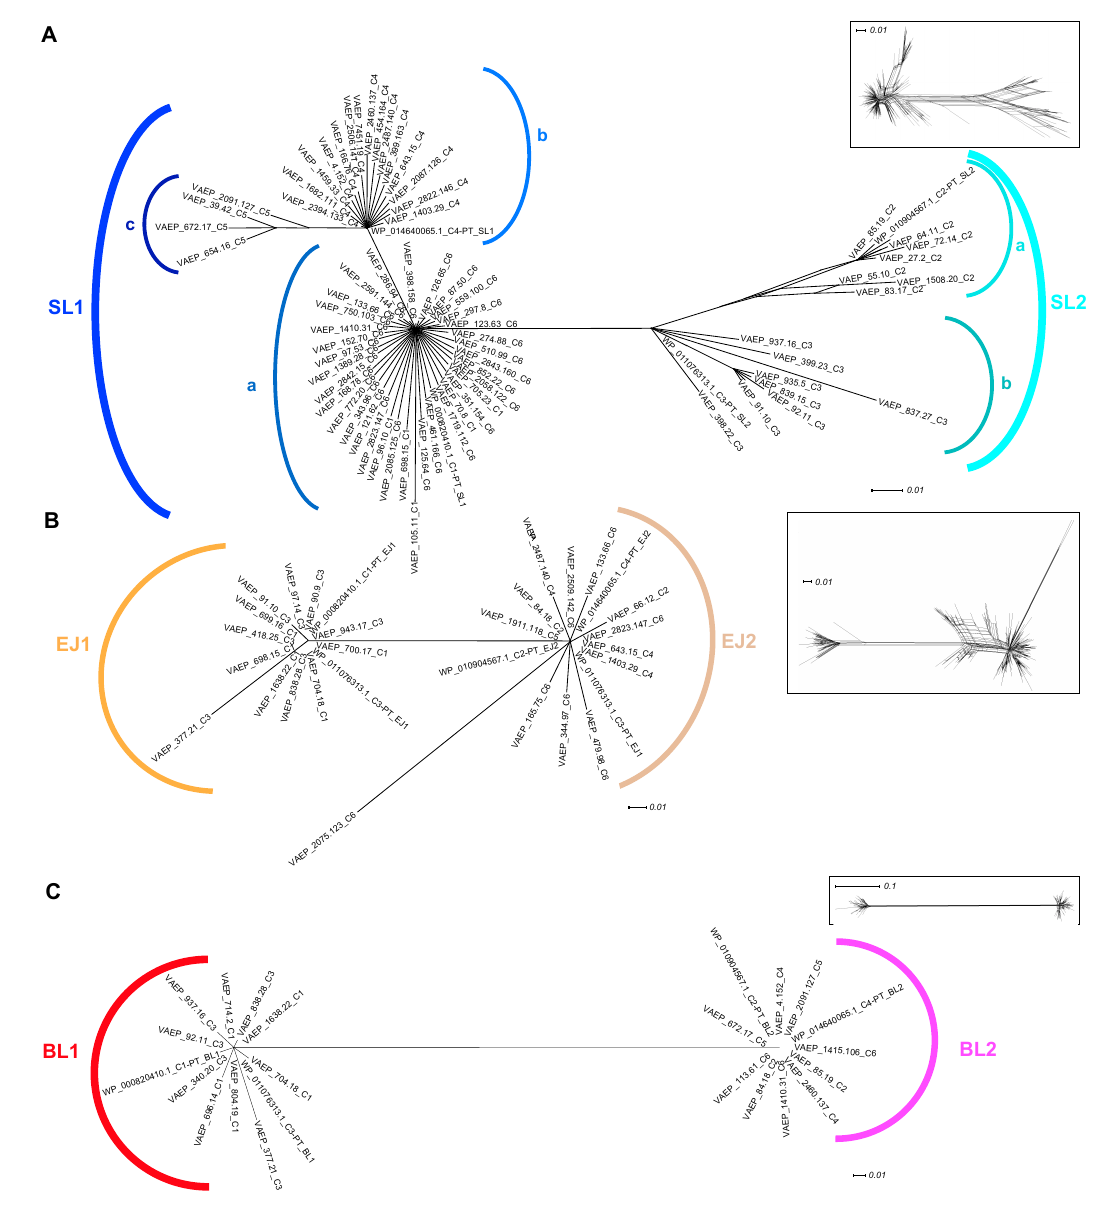
Figure 4. Phylogenetic analysis of the Ag43 passenger subdomains SL, EJ, and BL. Trees were generated using SplitsTree; inserts represent the trees before applying bootstrapping and confidence threshold. ( A ) SL subdomain from the Ag43 passenger respective to the types previously reported, namely SL1 and SL2 [29]; SL1 further split into subtypes a, b, and c, and SL2 into subtypes a and b. ( B ) EJ subdomain from the Ag43 passenger respective to the subtypes previously reported, namely EJ1 and EJ2 [29]. ( C ) BL subdomain from the Ag43 passenger respective to the subtypes previously reported, namely BL1 and BL2 [29]. For legibility, sequences that were identified but have not been included here are available in Table S1. Scale bars represent the evolutionary distance. SL1a corresponds to the SL1 originally identified in Ag43 C1-PT and contains Ag43 proteins classified as C1 as well as the newly identified C6. SL1b exclusively contains Ag43 of class C4, whereas SL1c includes the newly identified Ag43 C5 . Similarly, SL2a is present in Ag43 C2 and SL2b in Ag43 C3 passengers (Figure 4A). Overall, these findings showed that the Ag43 of C2-C5 classes were each associated with only a single SL2a, SL2b, SL1b, or SL1c subtype. The exceptions were the Ag43 C1 and Ag43 C6 which are both associated with the SL1a